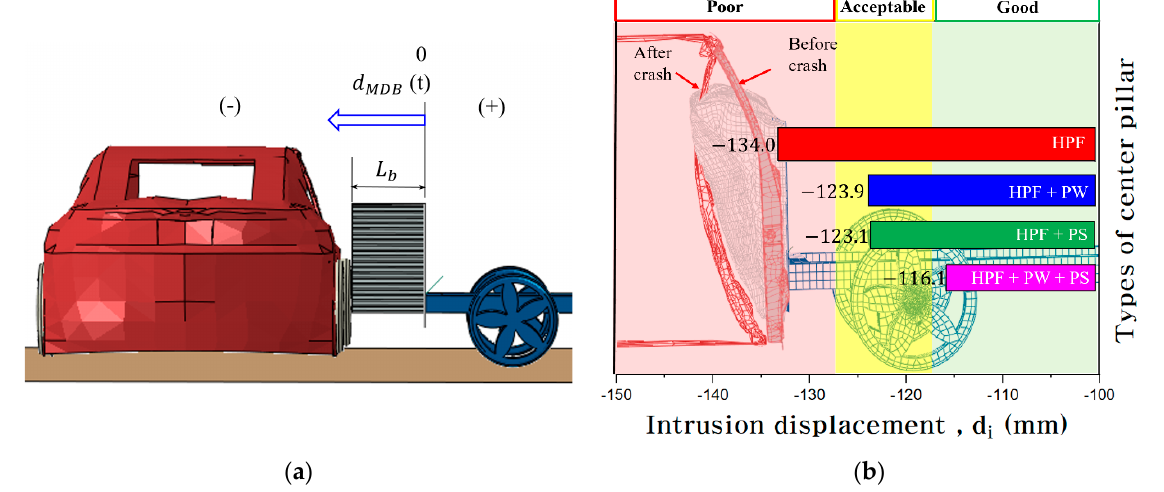
Figure 18. ( a ) Introduction of d MDB and L b . ( b ) Simulation data on intrusion displacement ( d i ) of the four kinds of center pillar.